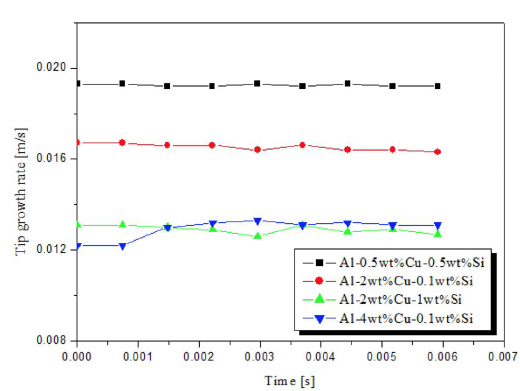
Figure 5. Tip growth rate as a function of time for: Al-0.5wt%Cu- 0.5wt%Si, Al-2.0wt%Cu-0.1wt%Si, Al-2.0wt%Cu-1.0wt%Si and Al-4.0wt%Cu-0.1wt%Si alloys.